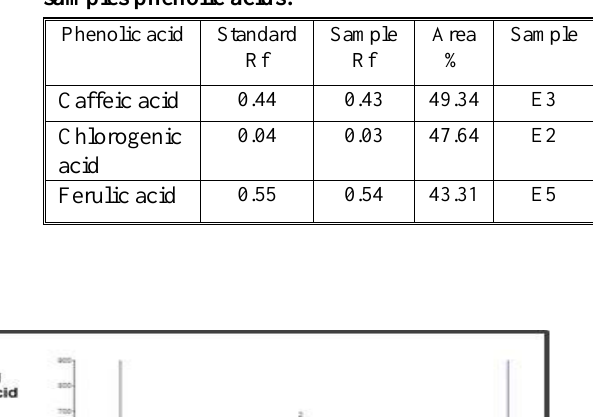
Table 2. Max R f values of the standard and